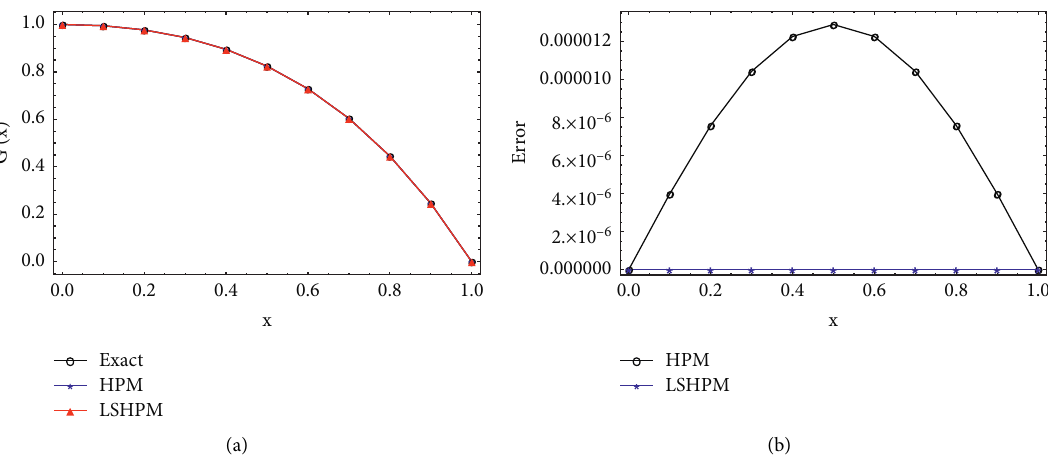
Figure 9: Graphical representation of solutions and errors in Problem 9. (a) Comparison of Exact, HPM, and LSHPM solutions. (b) Comparison of absolute errors of HPM and